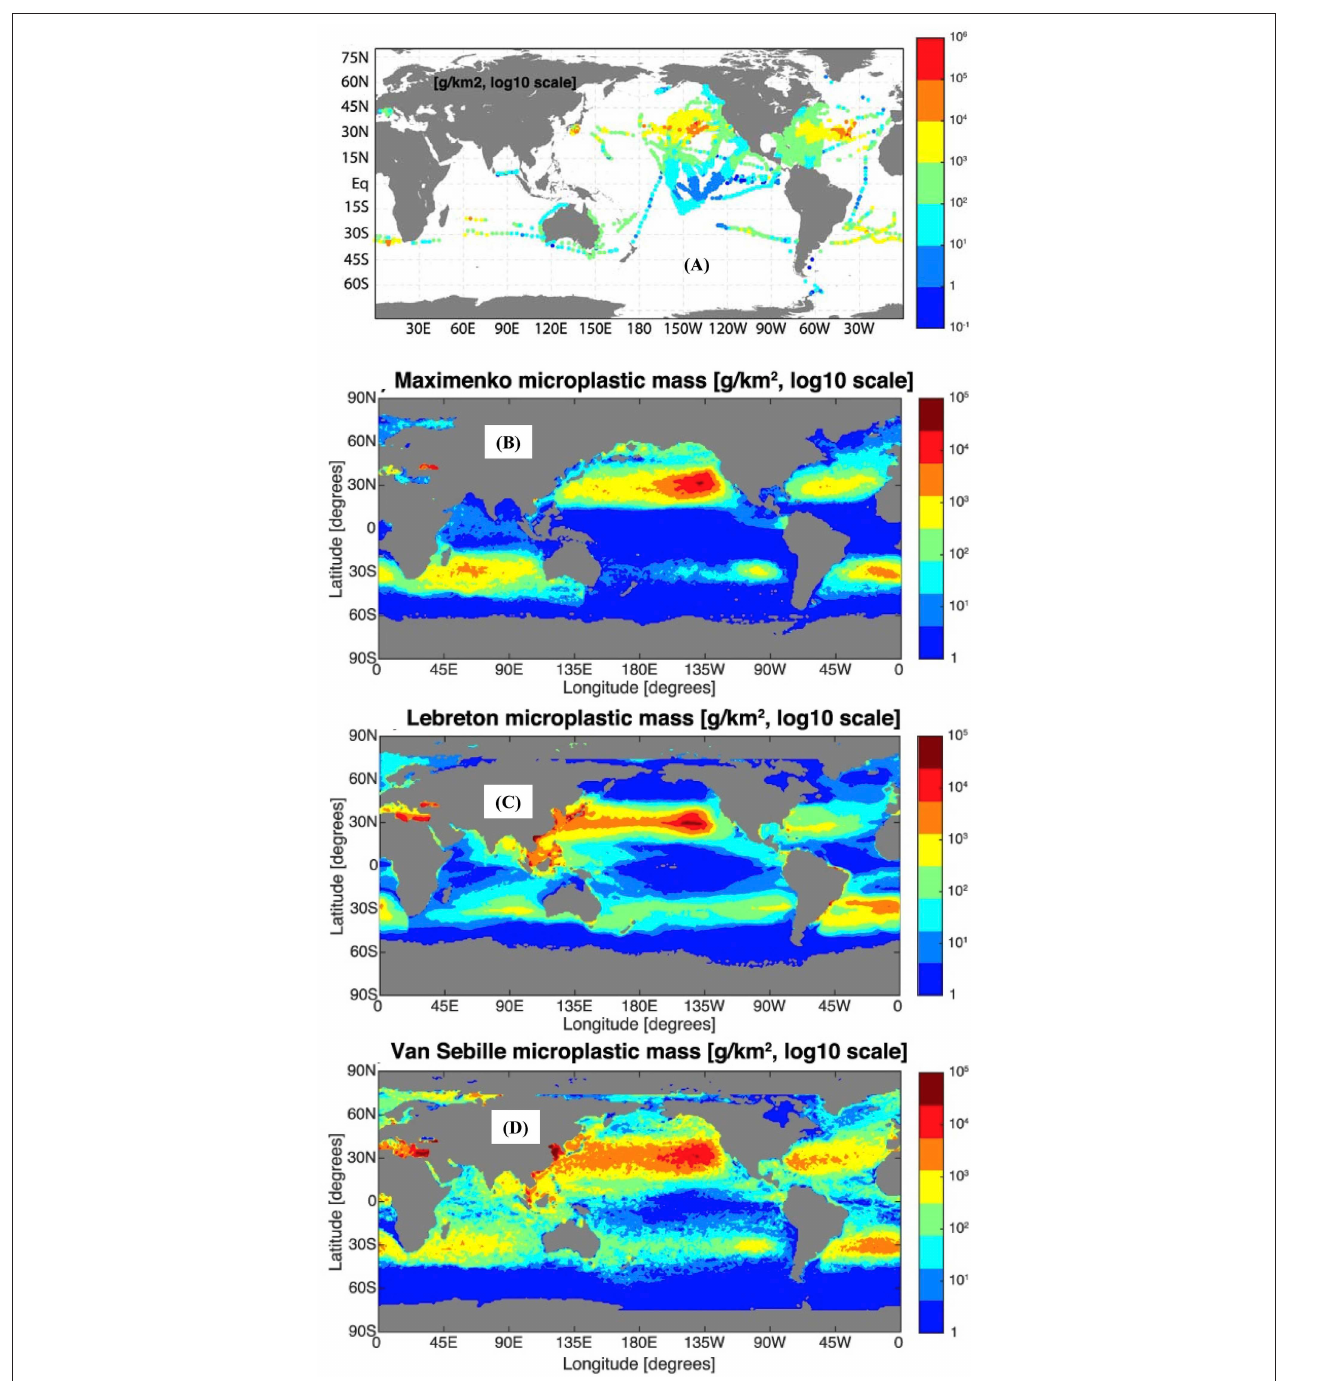
FIGURE 5 | (A) Density of microplastics near the ocean surface in the global dataset and (B–D) three model simulations [adopted from (van Sebille et al., 2015)] (Van Sebille holds copyright on this figure). observations are difficult to make, such as the high Arctic region (Cózar et al., 2017; Peeken et al.,